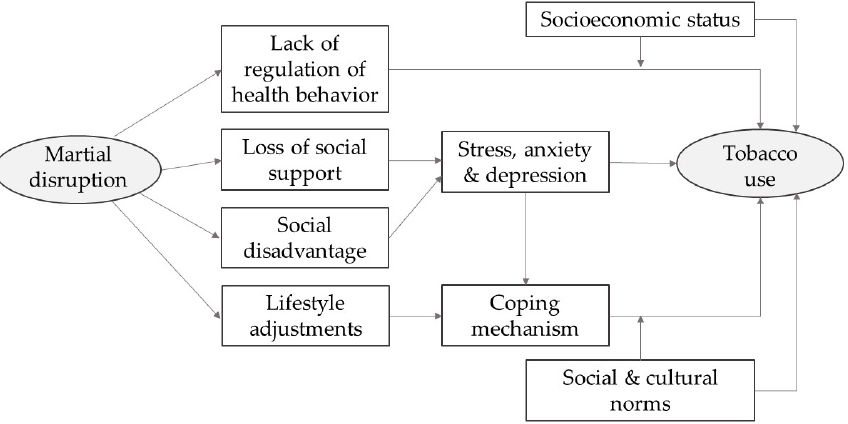
Figure 3. Conceptual framework of marital disruption and tobacco use.